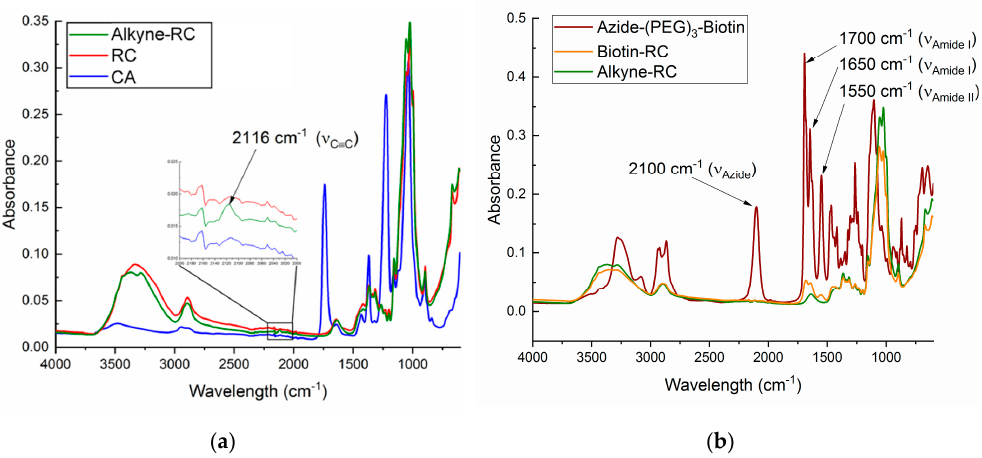
Figure 2. FTIR spectra of ( a ) as-spun CA, RC, and alkyne-RC nanofibers and ( b ) alkyne-RC, biotin-RC, and azide-(poly(ethylene glycol))biotin (azide-PEG3-biotin) conjugate. The alkyne peak at 2116 cm − 1 was small for FTIR, even at high concentrations of the alkyne group